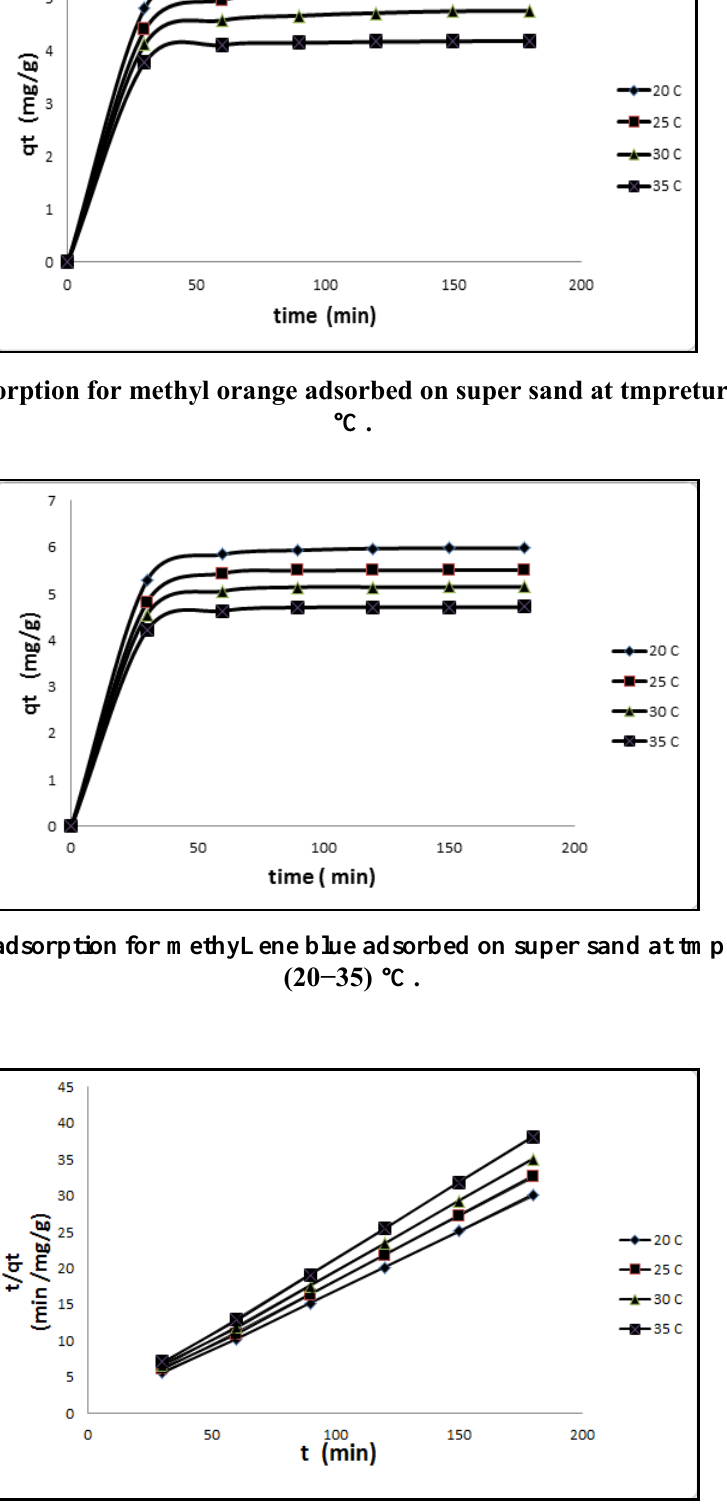
Fig. 9. second order kinatic model for methyl orange at tempreture range (20−35)